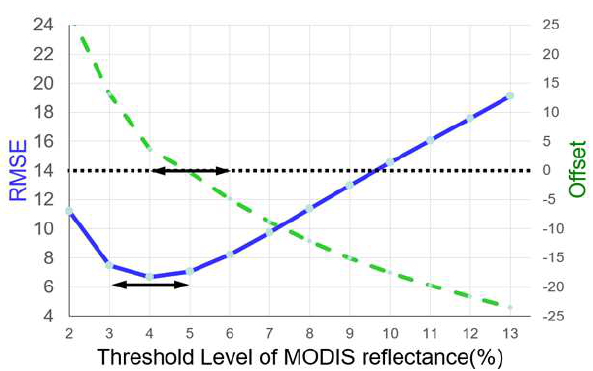
Figure 8. Relationship between threshold level and RMSE& Offset 7.2 Evaluation of AMSR2 sea ice concentration data The accuracy of AMSR2 sea ice concentration data were evaluated at the test sites in the Sea of Okhotsk, the Bering Sea and the Southern Ocean using the sea ice concentration data derived from MODIS data. The results are shown on Figure 9- 11 and Table 3.